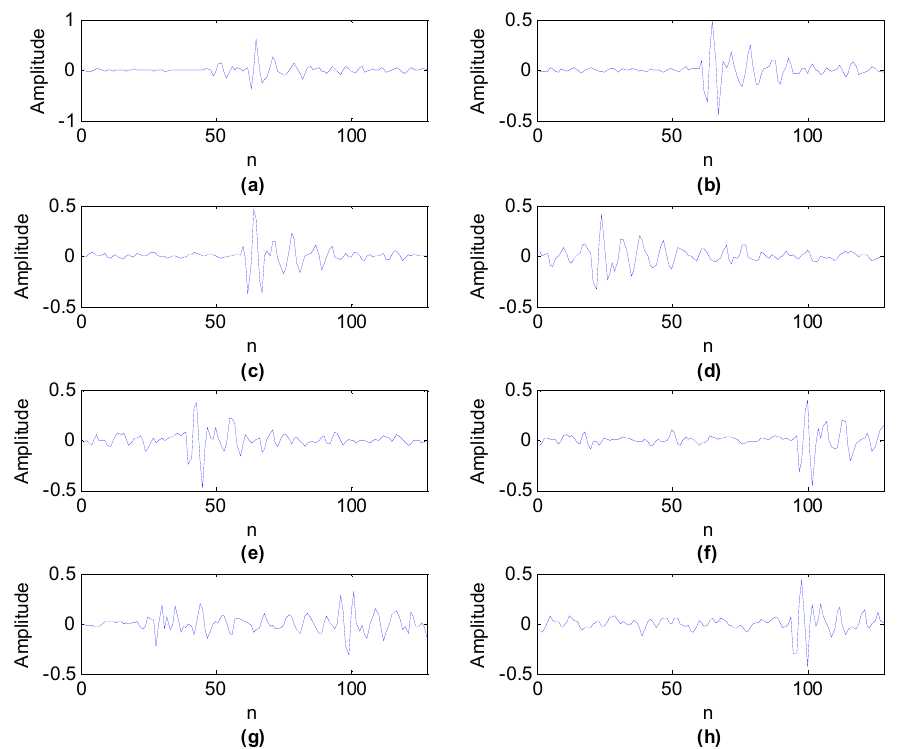
Figure 3. Rolling bearing signal with outer and inner race compound fault: ( a ) time waveform; ( b ) envelope spectrum.